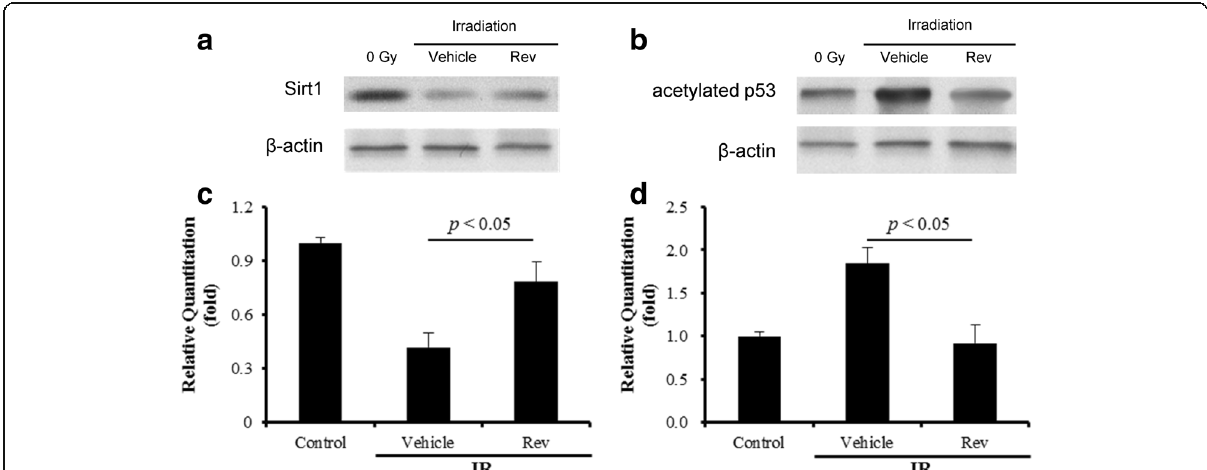
Fig. 5 Resveratrol moderates Sirt1, and acetylated p53 expression perturbed by irradiation in mouse small intestine. a The levels of Sirt1 expression; b the levels of acetylated p53 expression; ( c ) Quantitative analysis of the Sirt1 expression; (d) Quantitative analysis of the acetylated p53 expression. The data are presented as means ± SE. n = 6 mice per